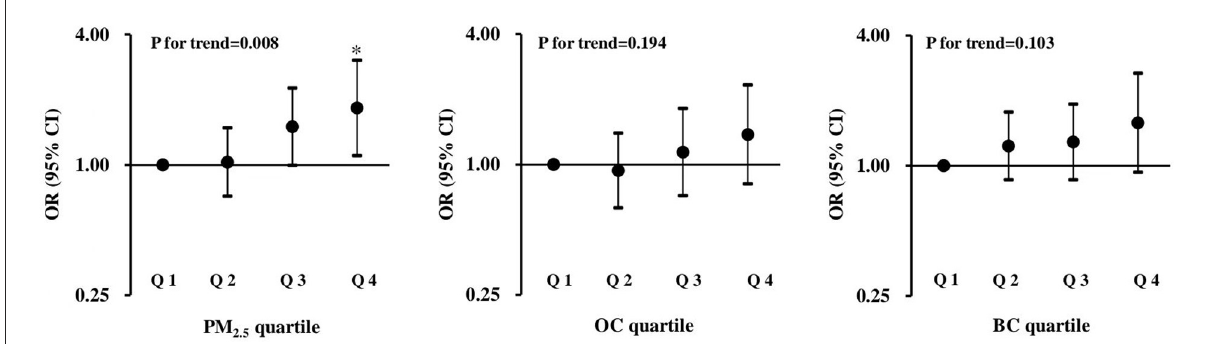
FIGURE1 ORs and 95% CIs for the associations between total PM 2.5 mass and two carbon constituents with preterm birth. The first quartile is the reference, and all models were adjusted for MA, prepregnancy BMI, gestational hypertension disorders, GDM, the use of ART, parity, twin chorionicity, twin growth discordance and the season of delivery. * p <